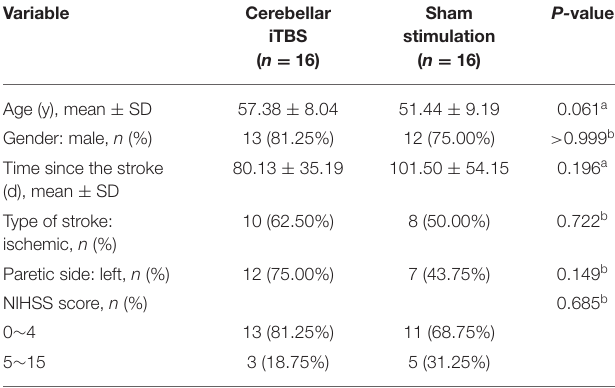
TABLE 1 | Characteristics of the